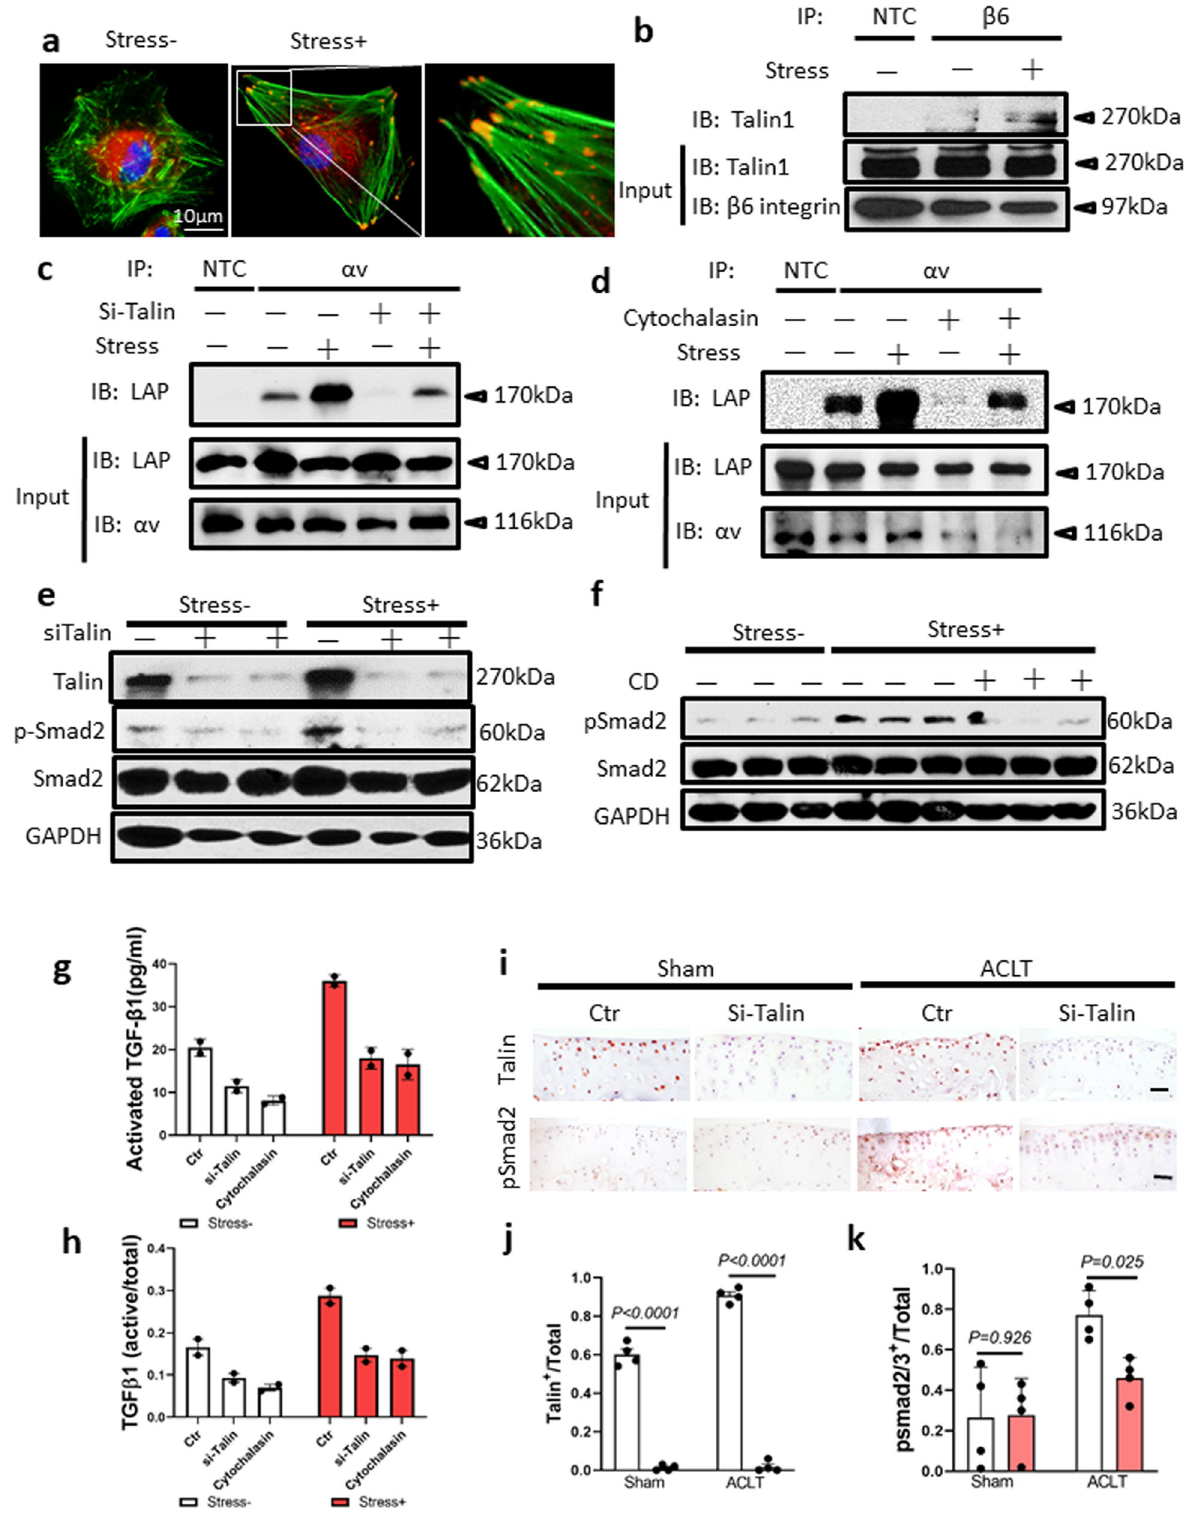
recombinant TGF β 1. Aggrecan production indeed decreased in the chondrocytes that were cultured in a high concentration of TGF β 1 (Supplementary Fig. 11b). Moreover, a high level of active TGF β increases chondrocyte stiffness in chondrocytes with or without shear stress measured by magnetic twisting cytometry (Supplementary Fig. 11c), suggesting that excessive TGF β